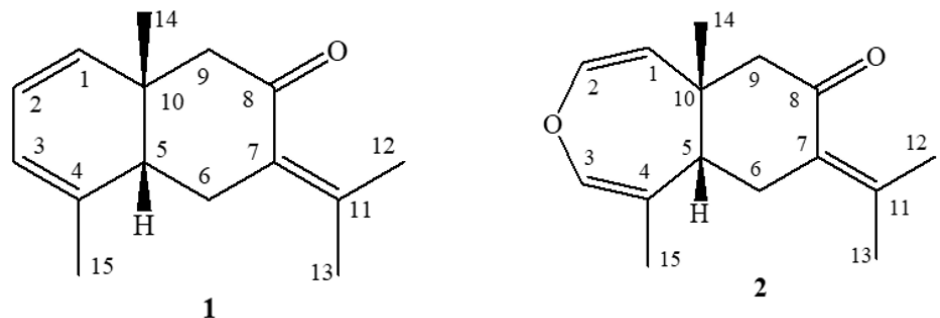
Figure 1. Chemical structures of selina-1,3,7(11)-trien-8-one ( 1 ) and oxidoselina-1,3,7-trien-8-one ( 2 ) presenting the relative stereochemistry in C-5 and C-10, as proposed in the literature [8].